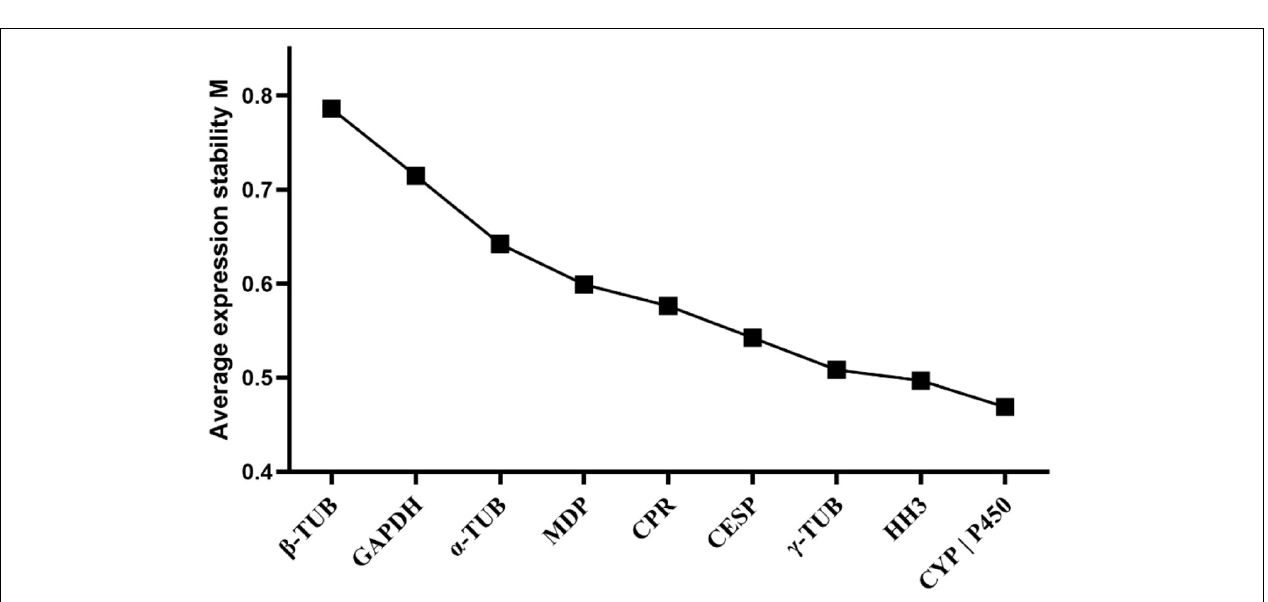
FIGURE 1 | Cycle threshold ( Ct ) values of 10 candidate reference genes across all samples at different development stages. The box indicates the 25th and 75th percentiles and the line in the box represents the median value.